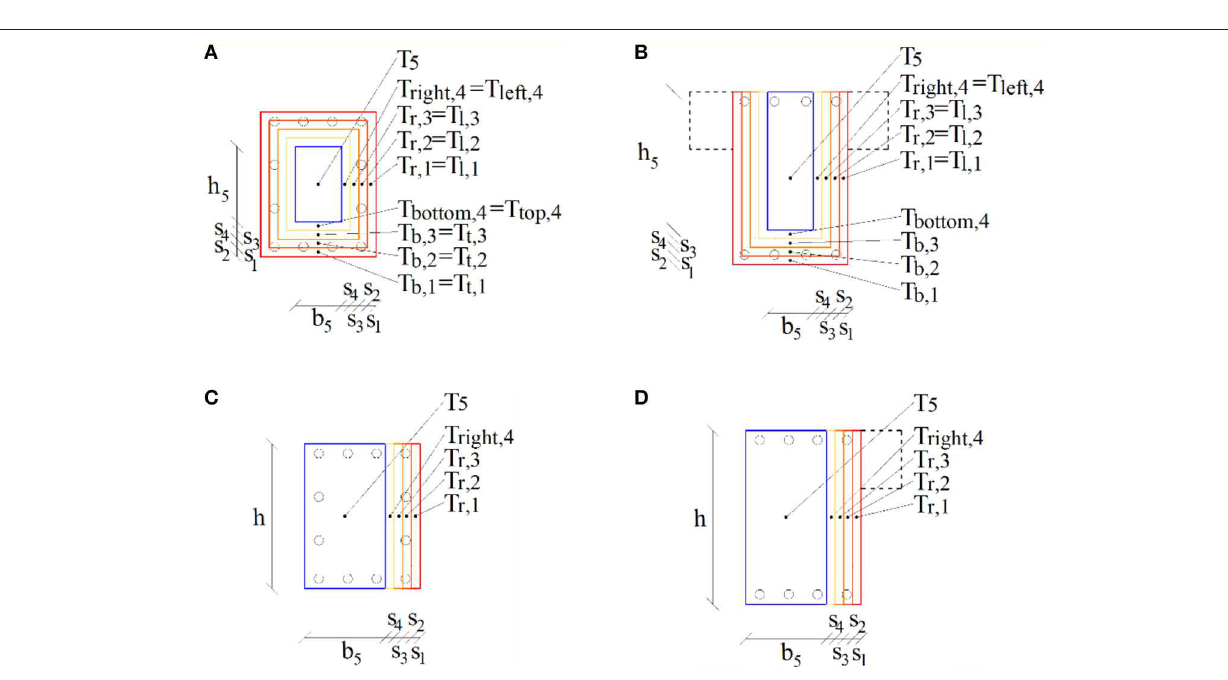
FIGURE 5 | Discretization of an r.c. cross-section with the variable isotherm method. (A) Interior column. (B) Interior beam. (C) Exterior column. (D) Exterior